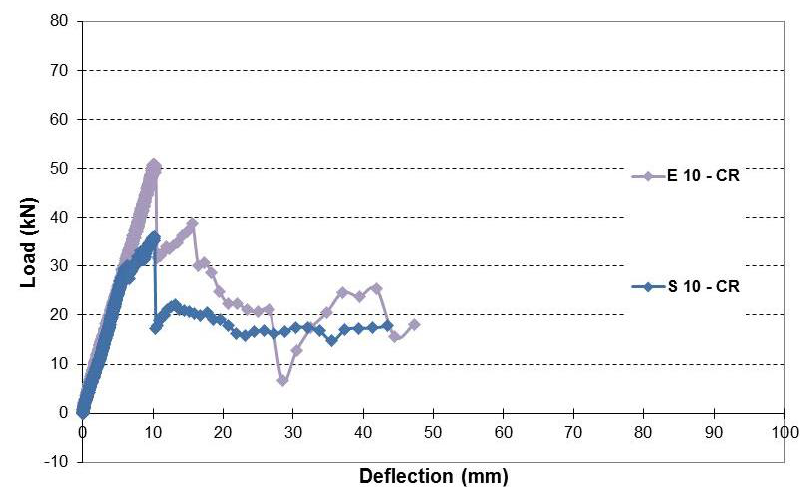
Figure 18. Load-deflection of beams with 10% corrosion levels (Repaired).